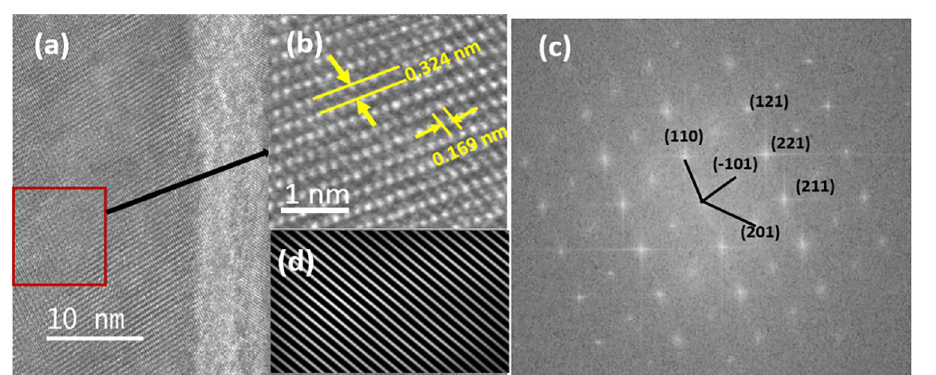
Figure 3. ( a ) HRTEM cross-sectional image of sample VT700; ( b ) Magnified HRTEM image of the rectangular marked region; ( c ) diffraction pattern of the crystallites of VO 2 ; ( d ) inverse FFT Lattice fringe obtained from out-of-plane spacing of 0.324